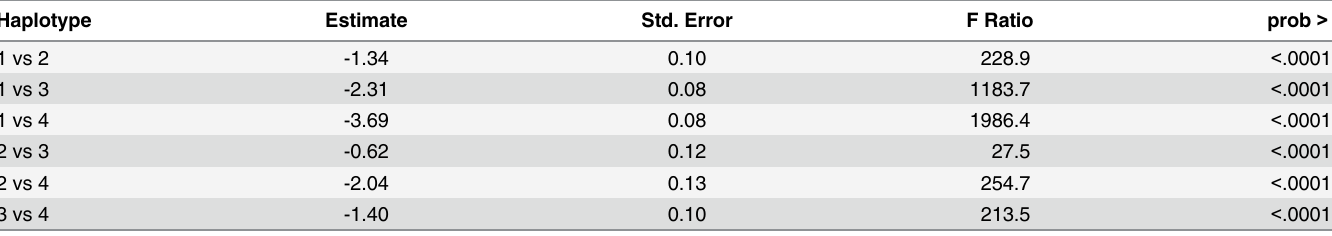
(Table 3). For ease of use, the two SNP loci will be referred to SNP3C and SNP18D moving for- ward. Two entries were not used in the haplotype analysis due to missing data at one of the two markers. All other entries fell into the four possible haplotypes (haplotypes 1 through 4) (Fig 2). Haplotype 1 contained the favorable allele ( “ + + ” ) at both loci and exhibited the lowest mean for BYDV tolerance (3.41). Haplotype 4 was constituted by having both unfavorable alleles ( “ - - ” ) at SNP3C and SNP18D. This haplotype displayed the highest mean BYDV toler- ance at 7.46. Haplotypes 2 (favorable allele at SNP3C and unfavorable allele at SNP18D, “ + - ” ) and haplotype 3 (unfavorable allele at SNP3C and the favorable allele at SNP18D, “ - + ” ) both had means that fell in between haplotype 1 and 4 (5.23 and 5.96). Contrasts between the four haplotypes were all significant at α = 0.05. Two different sets of near-isogenic lines (NILs) were included in the panel from the Univer- sity of Illinois at Urbana-Champaign [45]. Each set contains four lines and were developed using phenotypic selection. NIL family IL2250 contained four lines that ranged in BYDV rating from 3.14 to 6.98 (Table 4). NIL family IL2294 exhibited a similar range of BYDV ratings between 3.37 and 6.98. The haplotypes using SNP3C and SNP18D exhibited similar patterns in both families. In family IL2250, the two tolerant lines (IL2250-18 and IL2250-14) both had BYDV BLUPs of Table 3. Contrasts between haplotypes for BYDV tolerance in oat.